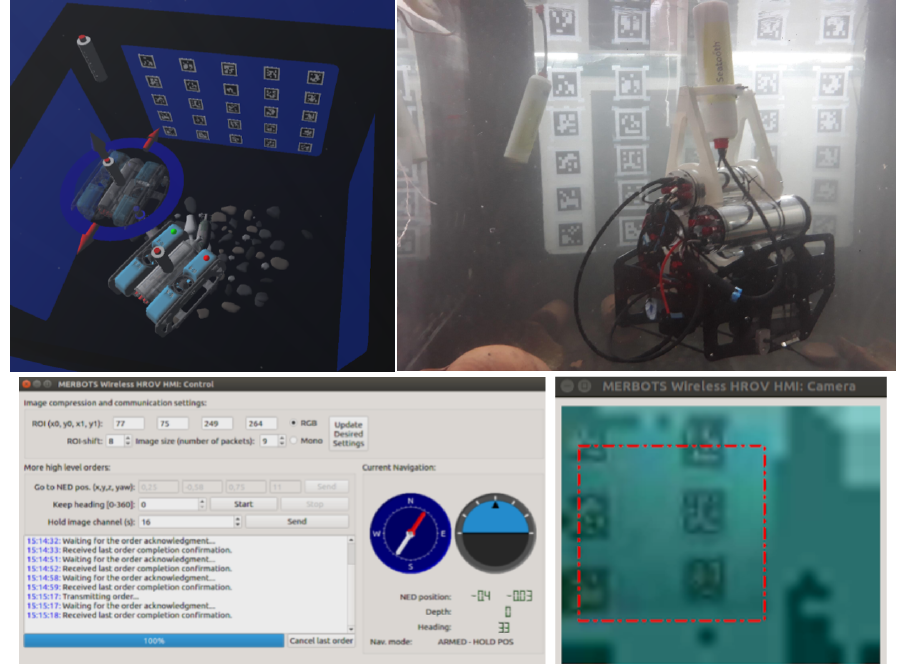
Figure 20. Underwater radio frequency experiments for robot teams: ( top left ) predictive 3D module to teleoperate the wireless underwater robot, where the opaque robot represents the current position and the transparent robot represents the required one; ( top right ) underwater robot and wireless modem; ( bottom left ) user interface of the network; and ( bottom right ) Region-Of-Interest (ROI)